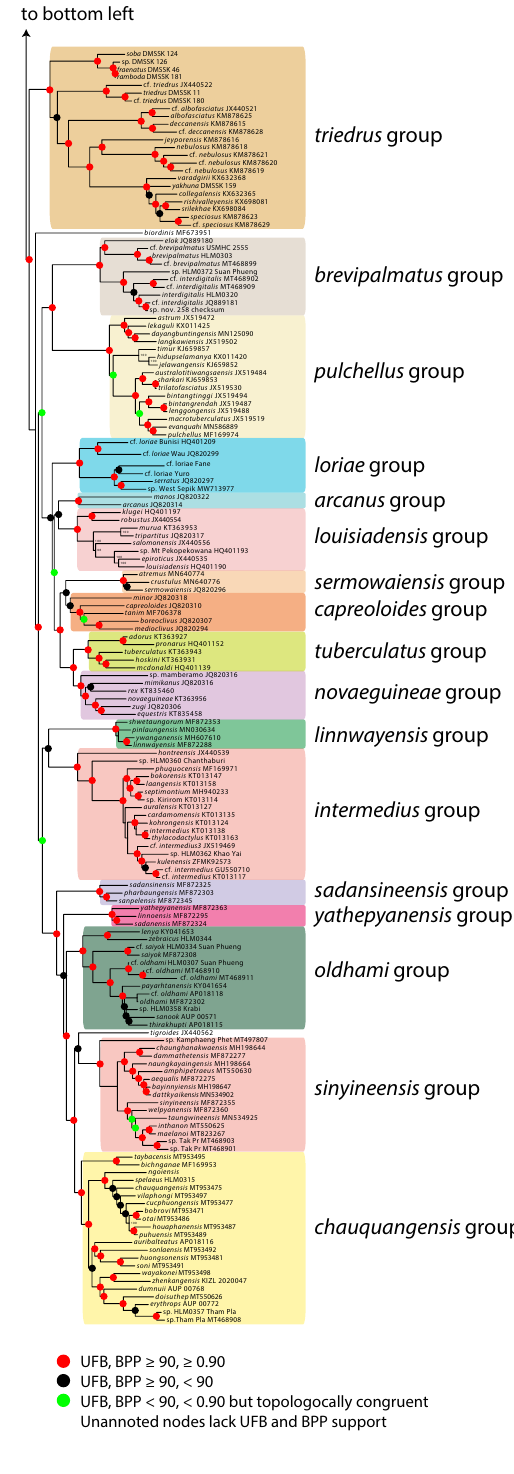
Figure 6. Majority-rule consensus tree from ML bootstrap replicates of 344 species of Cyrtodactylus. Phylogeny based on 1474 base pairs of the mitochondrial gene ND2 illustrating the designation of 32 monophyletic species